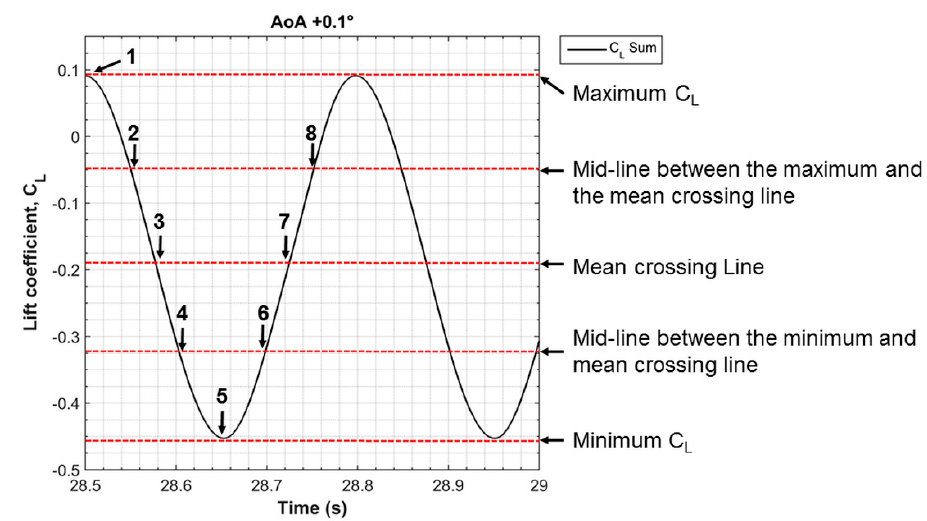
Figure 6. Eight time instances during one vortex shedding cycle which are investigated in Figure 7 (AoA = +0.1°).